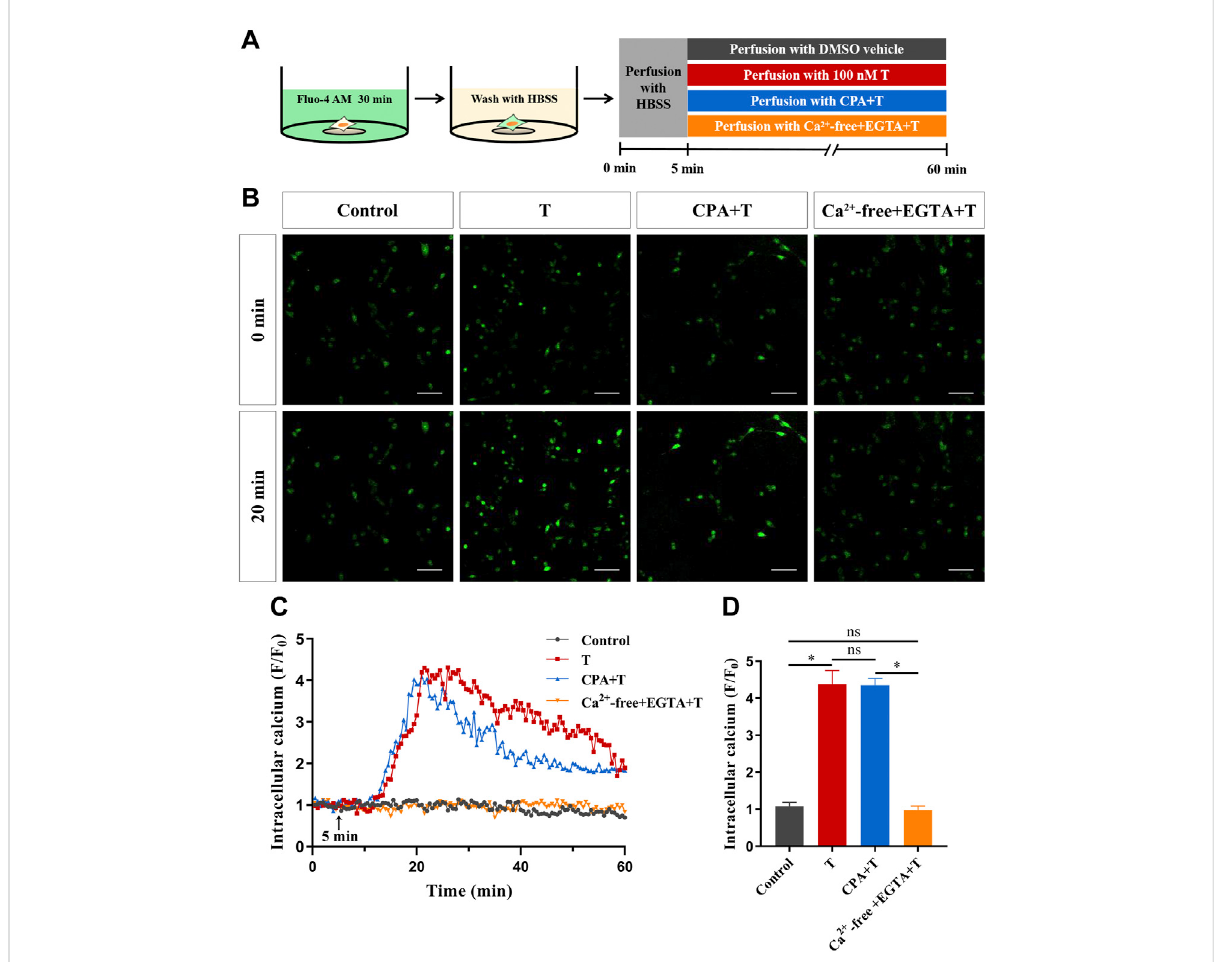
FIGURE 5 The source of increased intracellular Ca 2+ induced by T in HT22 cells. (A) Schematic diagram of calcium imaging in the calcium source experiment in HT22 cells labeled with Fluo-4AM. (B) Fluorescence images of the calcium source in Fluo-4AM-labeled HT22 cells. Scale bars = 50 μ m. (C) Representative traces showing changes in Ca 2+ (F/F0) induced by T when HT22 cells were cultured in calcium-containing and calcium- free extracellular fl uids. The black arrow indicates when the HT22 cells were treated. (D) Statistical graph showing the changes in Ca 2+ (F/F0) induced by T when HT22 cells were cultured in calcium-containing and calcium-free extracellular fl uids (ns: non-signi fi cant; * p <